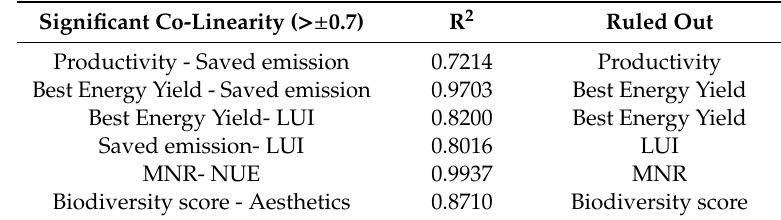
Table 4. Significant co-linearities with the goodness-of-fit for the linear trend line and the indicators that have been ruled out from the analysis between species.